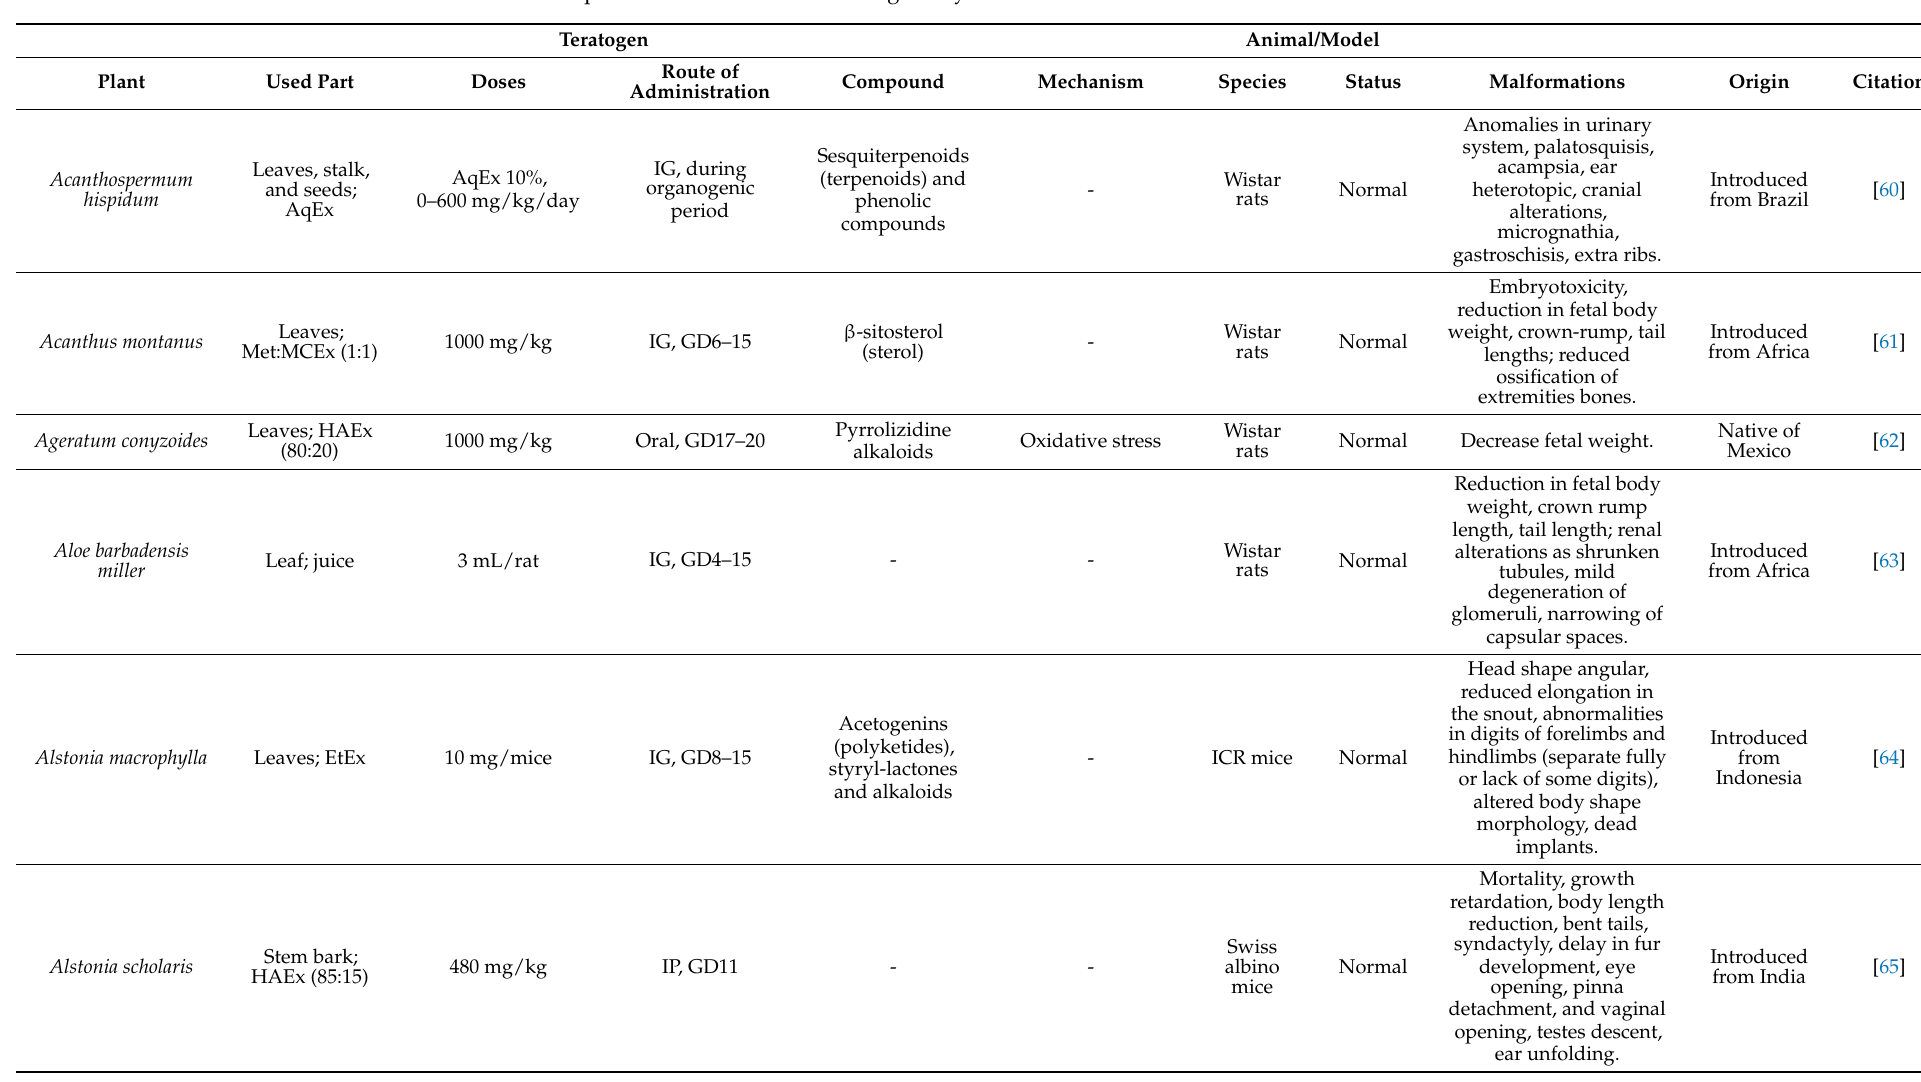
Table 1. List of Mexican plants screened for their